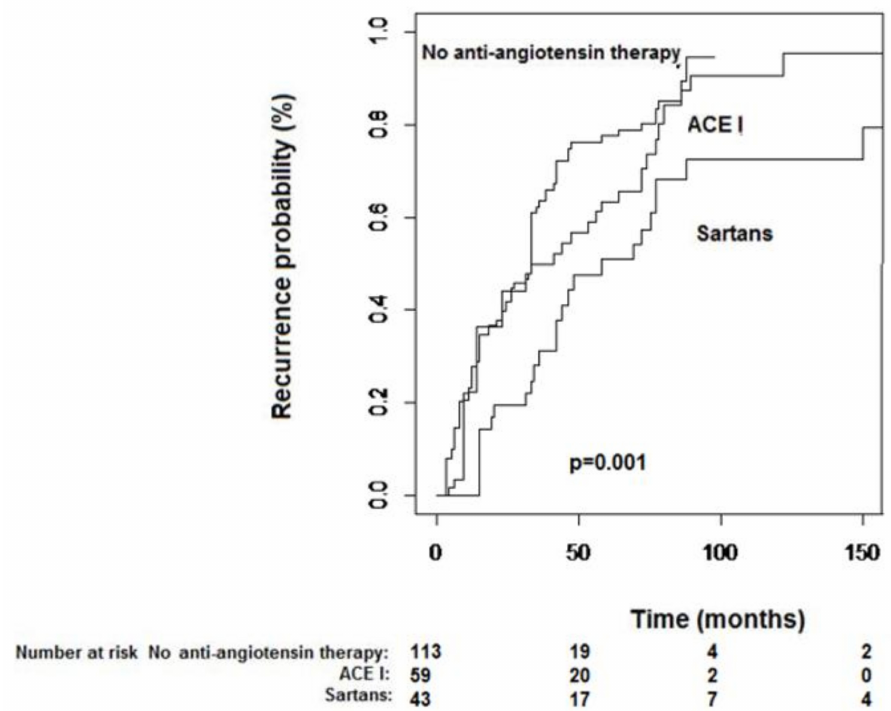
Figure 2. Kaplan–Meier curves of time-to-recurrence stratified by anti-hypertensive therapy.Median time-to-recurrence was 33 months (24–35) in group 1, 41 (23–72) in group 2 and 51 months (42–88) in group 3 ( p =